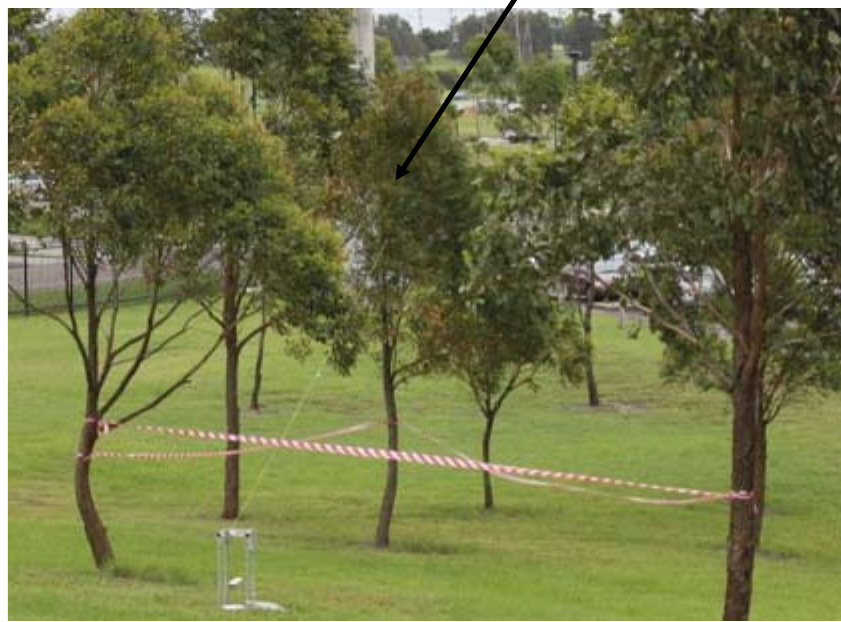
Figure 2. Tree used for experimentation and development of movement harvesting device, as indicated by